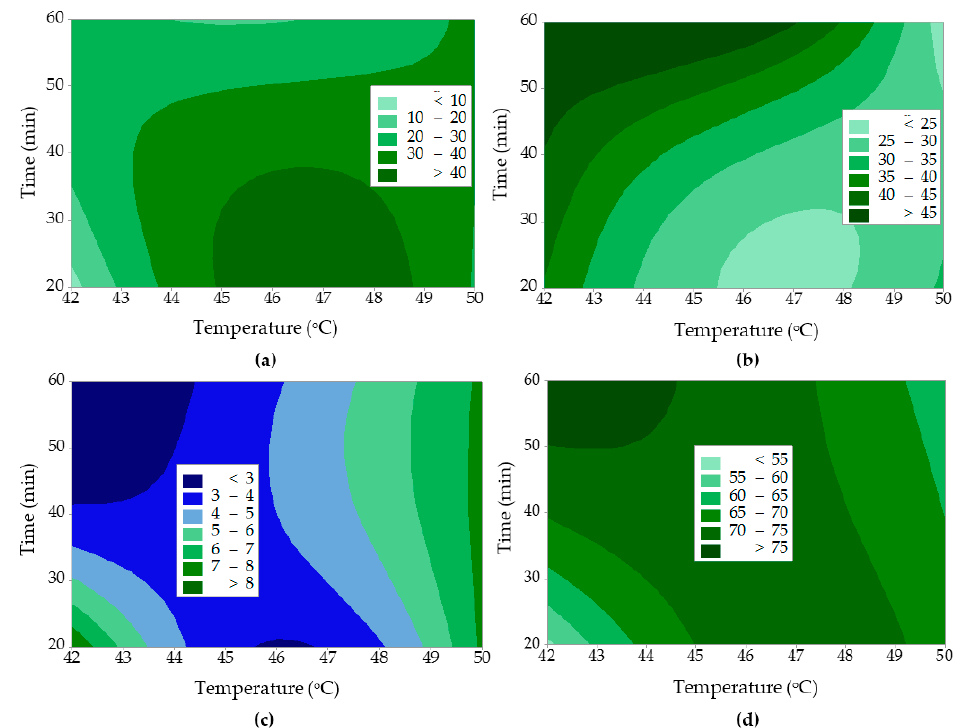
Figure 1. The influence of extraction temperature at 1st extraction step and extraction time at 1st extraction step on gelatin yields: ( a ) the yield of the 1st gelatin fraction; ( b ) the yield of the 2nd gelatin fraction; ( c ) the yield of the 3rd gelatin fraction; ( d ) the total yield of gelatins. If we compare the yields of gelatins (Y G1 , Y G2 , and Y G3 ) prepared according to our